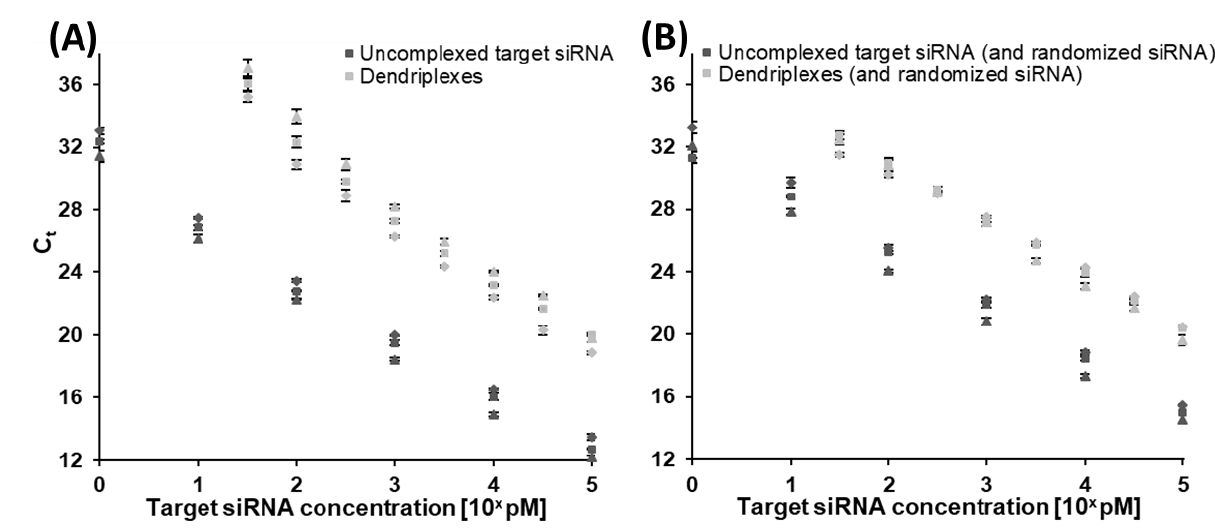
Figure 4. Standard curves, indicating intra and inter assay reproducibility and linearity of the RT- qPCR assay. Dilution series of anti-Smad6 (target) siRNA under varying conditions. Threshold cycle (C t ) values of each three separate calibration curves without ( A ) or with ( B ) additionally added randomized siRNA at a constant concentration of 1 µM and with uncomplexed target siRNA or dendriplexes (constant N/P-ratio of 5 in all dilution steps, taking only target siRNA and not randomized siRNA into account). Threshold for determination of C t values was kept constant at 0.03 relative fluorescence units in all experiments. All dilution series were performed three times in separate experiments (biological triplicates, represented as squares, triangles and diamonds respectively), each with technical triplicates. Arithmetic means and sample standard deviations are plotted. Indicated concentrations are final concentrations in PCR-ready samples.